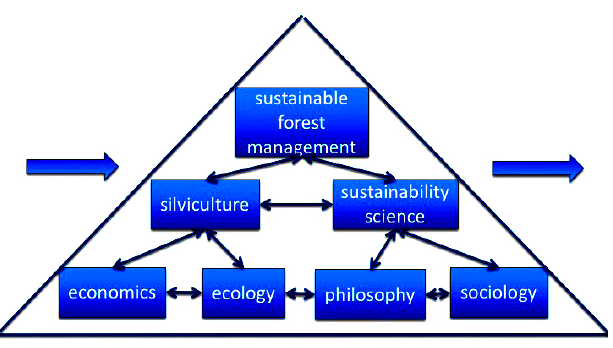
Fig. 2 . (Part of) Jantsch’s (1972) evolutionary ladder of interdisciplinarity, adapted from Thorén and Persson